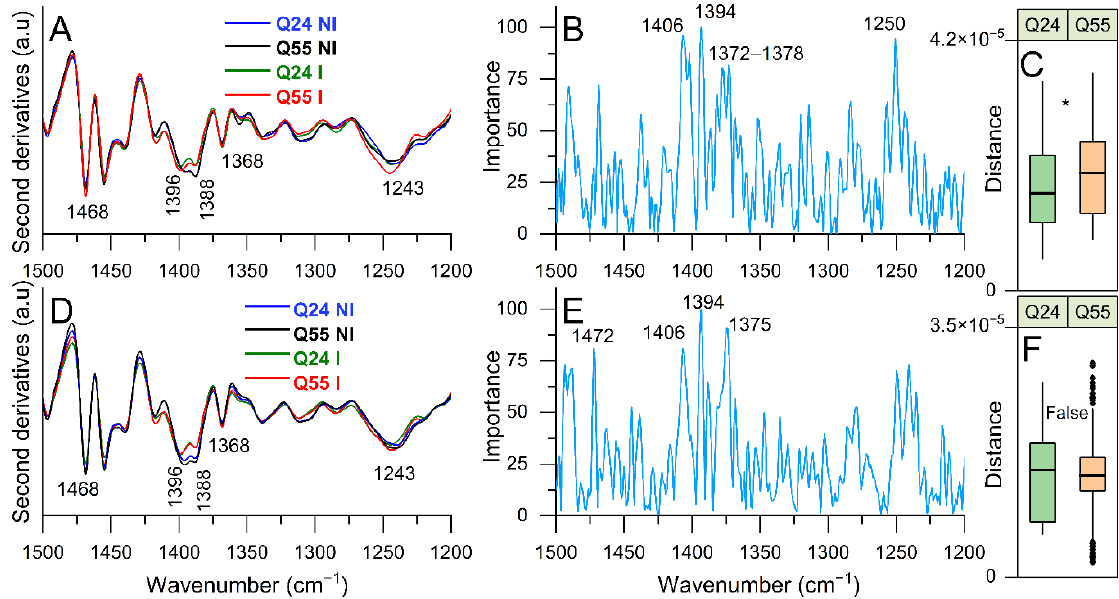
Figure 6. FTIR analysis of the 1500–1200 cm − 1 spectral range. The second derivatives of representative FTIR spectra, identified by PLS-DA, of E. coli cells expressing ATX3-Q24 and ATX3-Q55 at 5 ( A ) and 8 ( D ) hours of induction, and of NI cells are reported. In ( B ) (5 h) and ( E ) (8 h), the loading plots representing the spectral components more relevant for the discrimination between the classes are displayed. In ( C ) (5 h) and ( F ) (8 h), the distribution of distances between I and NI is represented as box plots, as in Figure 4. The reported spectroscopic analyses were performed on spectra from three independent experiments, where 5–7 spectra were collected for each condition in each experiment. *: p -value < 0.05.